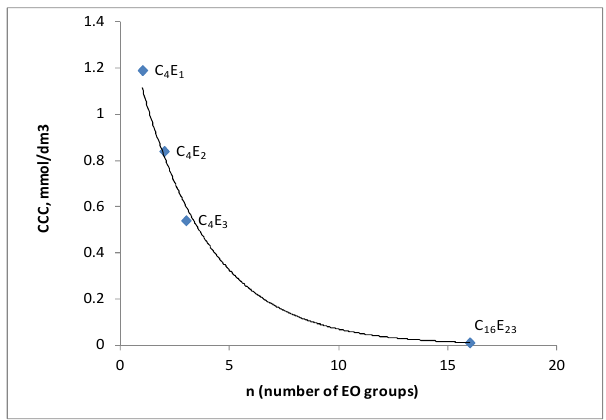
Figure 6. Effect of a number of (EO) groups per molecule on CCC values for the polyglycol frothers.